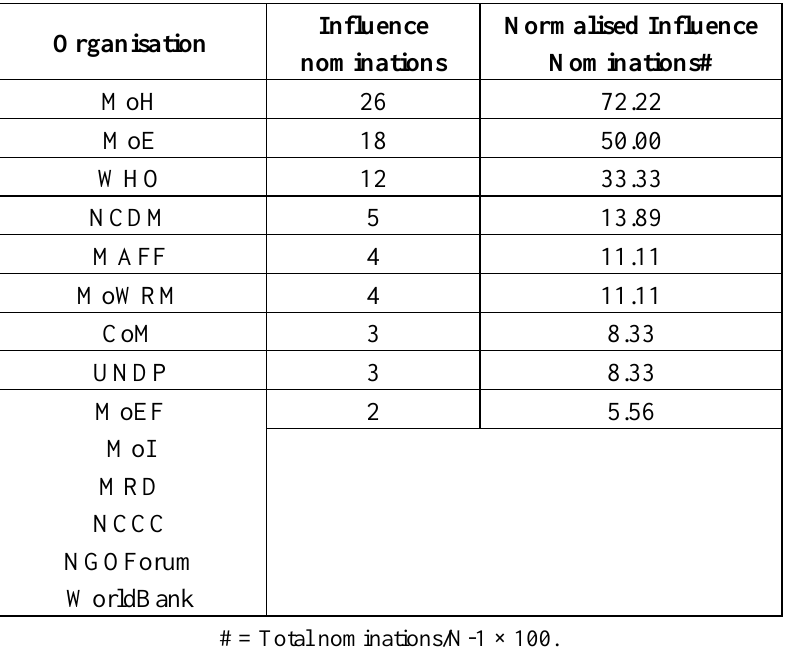
Table 6. Influence nominations for health and climate change organisational influence in Cambodia.